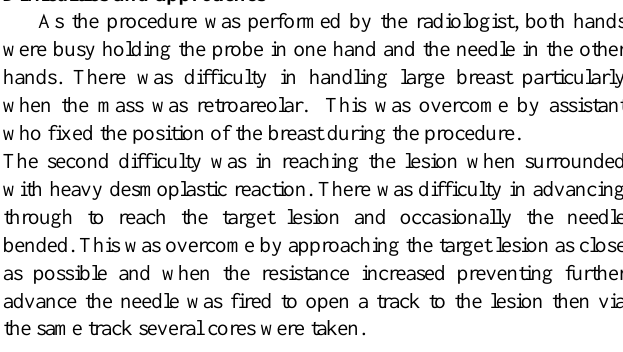
Table 6: The validity of core needle biopsy test Core needle biopsy